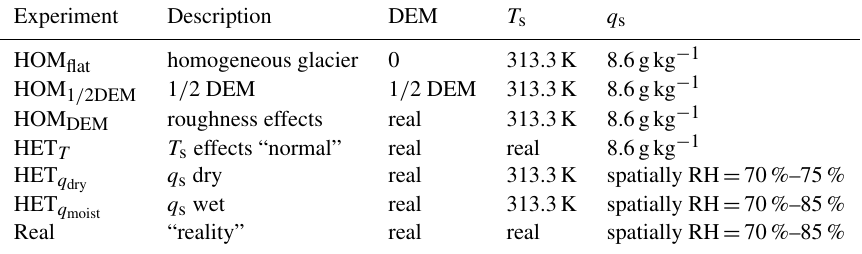
Table 1. Overview of experiments done with MicroHH. The DEM indicates the boundary condition used for the topography (0 means no DEM, 1 / 2 DEM is the original DEM halved in height, real is the spatially measured value), T s is the surface potential temperature (313.3K is a homogeneous value, real is the spatially measured value), and q s is the surface specific humidity (8.6gkg − 1 is a homogeneous value; the choice for the relative humidity range is described in Sect.